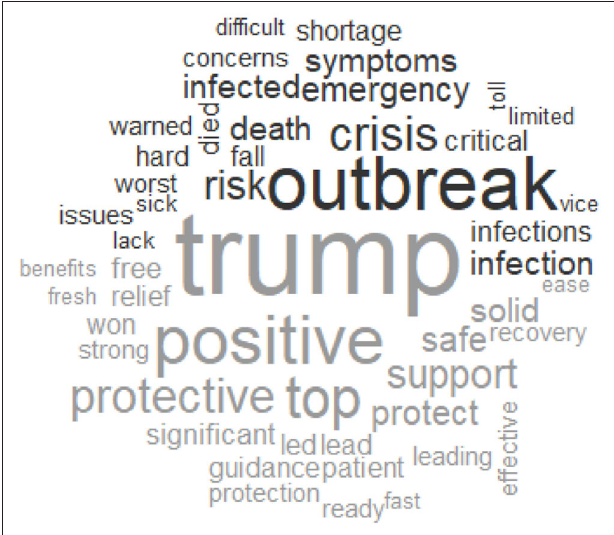
FIGURE 5 | GN word cloud with sentiment (negative, top; positive, bottom).